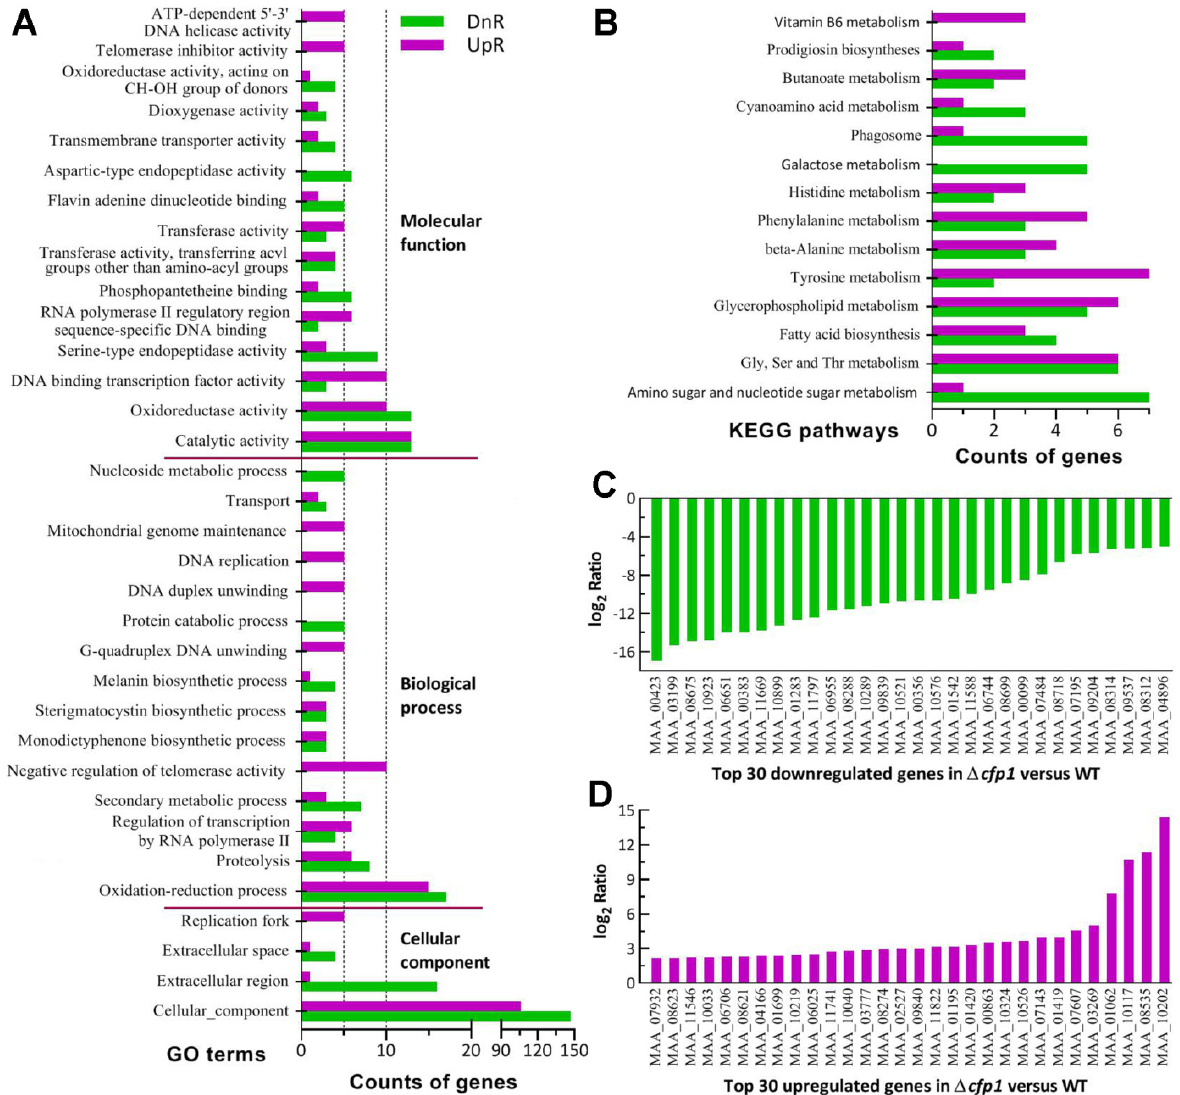
Figure 4. Effect of cfp1 deletion on genome ‐ wide gene expression of M. robertsii . ( A ) Counts of differentially expressed genes (DEGs) significantly enriched ( p < 0.05) to three function classes (main GO terms shown; see Table S4 for all GO terms). ( B ) Counts of DEGs significantly enriched ( p < 0.05) to KEGG pathways. The transcriptome was constructed based on three 3 d ‐ old cultures (replicates) of the Δ cfp1 and WT strains. All DEGs were identified at the significant levels of log 2 ratio ( Δ cfp1 /WT) ≤ − 1 (downregulated, DnR) or ≥ 1 (upregulated, UpR) and q < 0.05. ( C , D ) The log 2 ratio values of top 30 down ‐ and upregulated genes.